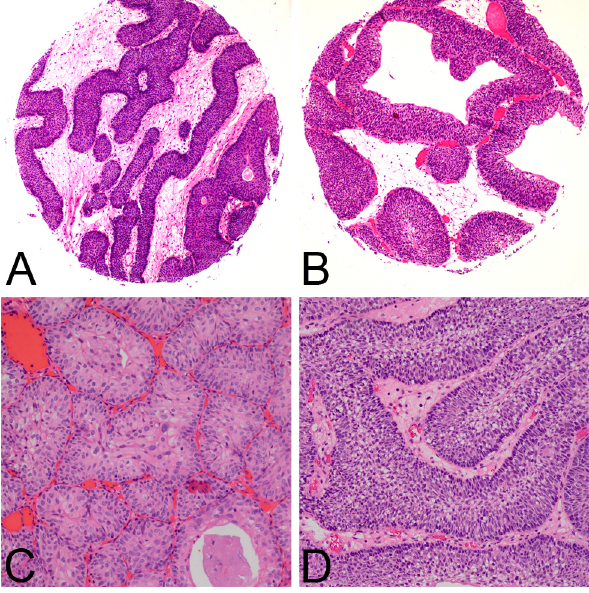
Fig 1. Clinicopathological features of inverted papilloma. IUPs were mainly comprised anastomosing cords, which were thin and congruous in width (A) , or nests (C) . Cysts were occasionally observed in the interiors of the nests (B) . Peripheral palisading nuclei were observed (D) .